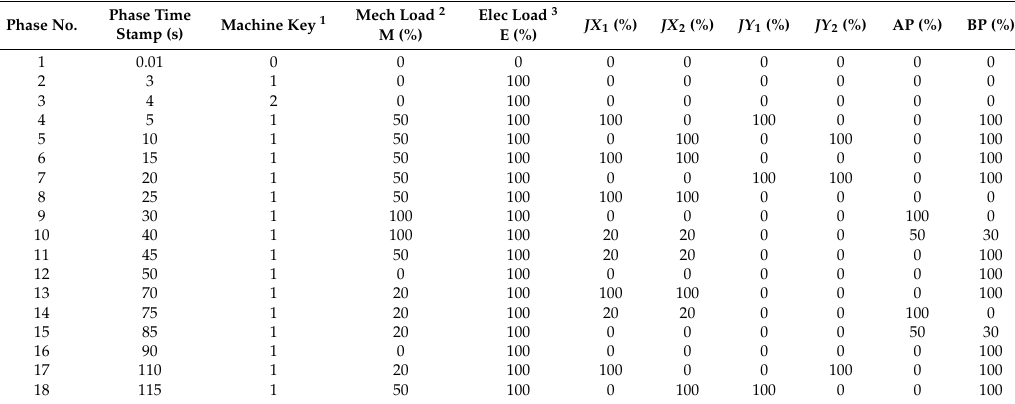
Table 4. A simulated working cycle for heavy